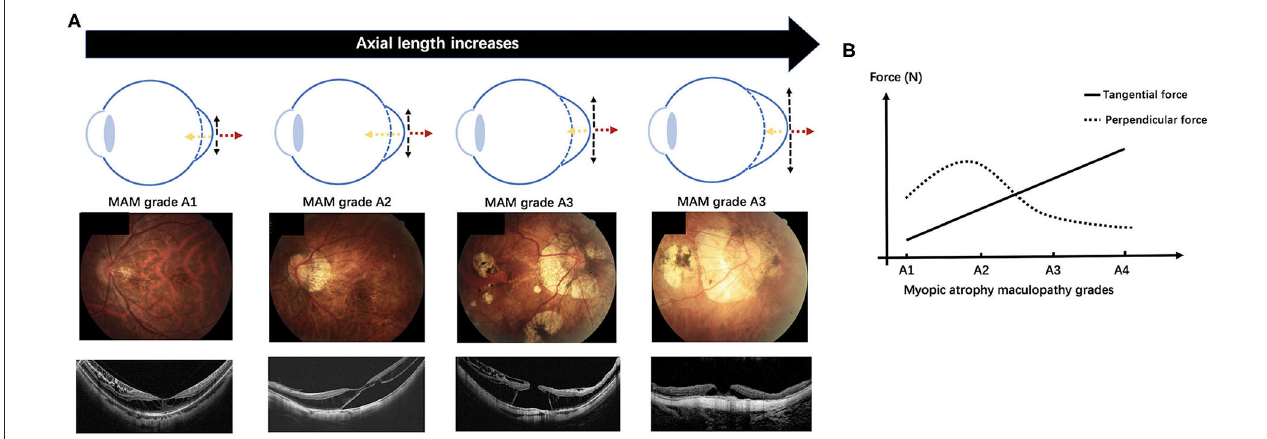
FIGURE 4 | We proposed a hypothesis on the mechanics-related changes of pathologic myopia based on the study. In the early stage of pathologic myopia, the macular is mainly affected by the perpendicular force, which gradually increases under the inward pulling force of the vitreous and the backward pulling force of posterior sclera extension, and reaches the highest at the myopic atrophy maculopathy (MAM) grade A2. After A2, the vitreous might be liquefied and reduce the inward force. The summation of perpendicular force falls and the tangential force gradually increases becoming the dominant factor causing retinopathy. (A) A schematic diagram demonstrates the change of the perpendicular force and the tangential force acting on the macular with the axial length growth (the top row). Fundus images with increasing MAM grades (the middle row) and optical coherence tomography images which show the corresponding myopic tractional maculopathy (the bottom row). (B) The variation trend of the perpendicular force and the tangential force with MAM grades increasing in the hypothesis. Myopic atrophy maculopathy, MAM; A1, tessellated fundus; A2, diffuse chorioretinal atrophy; A3, patchy chorioretinal atrophy; A4, macular atrophy. Black dotted arrow, the tangential force; yellow dotted arrow, the inward pulling force of the vitreous; red dotted arrow, the backward pulling force of the posterior sclera extension.